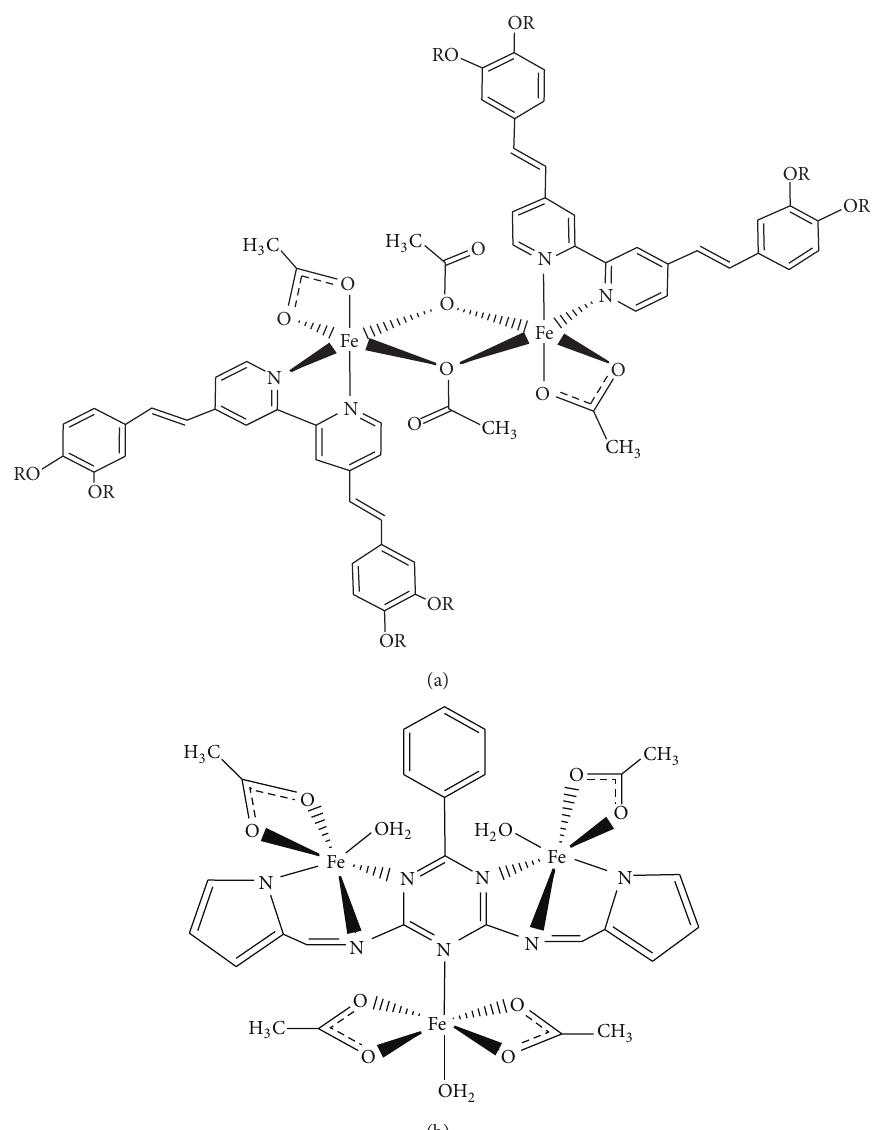
Figure 1: Proposed structures of (a) 1 (R = CH 3 (CH 2 ) 13 and (b) 2